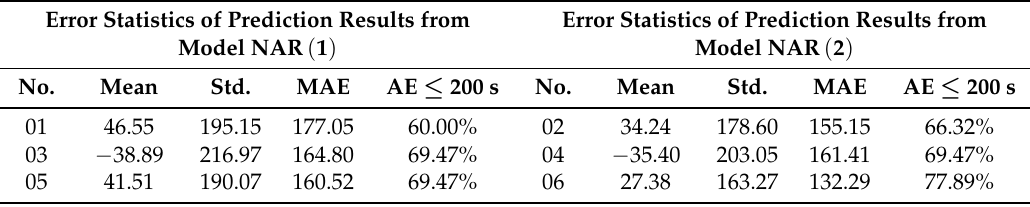
Table 4. Comparison of the prediction errors from NAR ( 1 ) and NAR ( 2 ) . Error Statistics of Prediction Results from